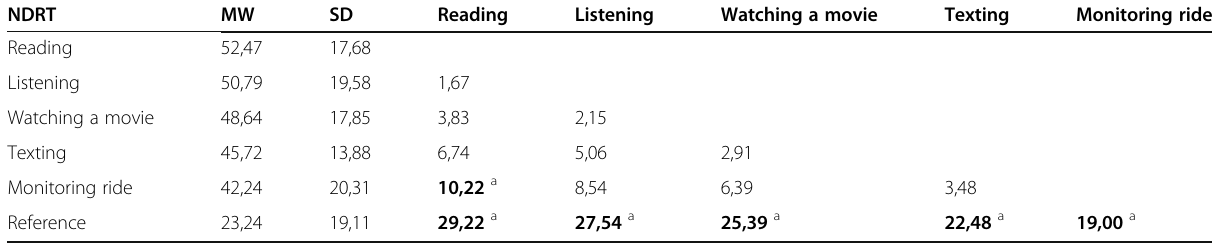
Table 1 Overview of the results NASA-TLX - total score (weighted) in points NDRT MW SD